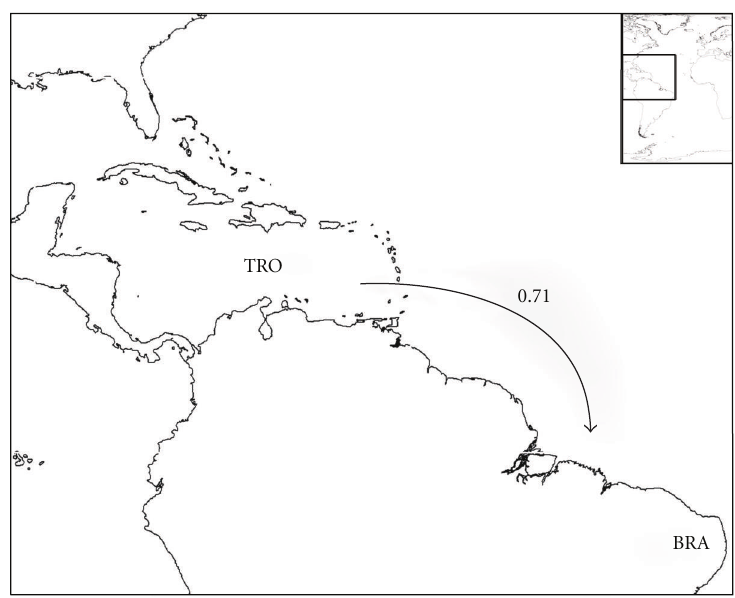
Figure 3: Probable colonization patterns of rissoid fauna in the central west - Atlantic. The arrows represent the probable main flux direction of faunas, and the associated numbers represent, for each pair of areas, the higher of the two similarity index values computed as described in the methods, abbreviations as in Table